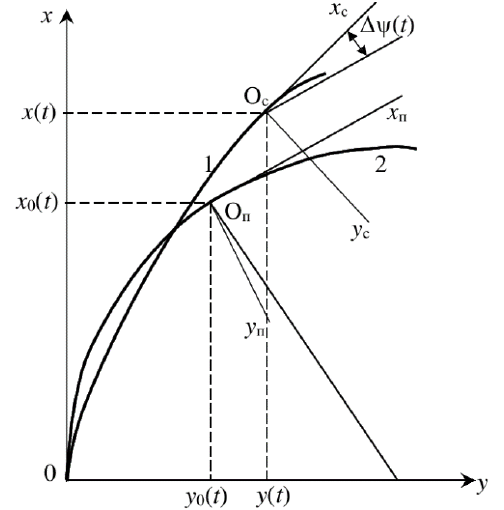
Figure 2. Deviation of the actual movement of the bus from the required: 1 – the current trajectory; 2